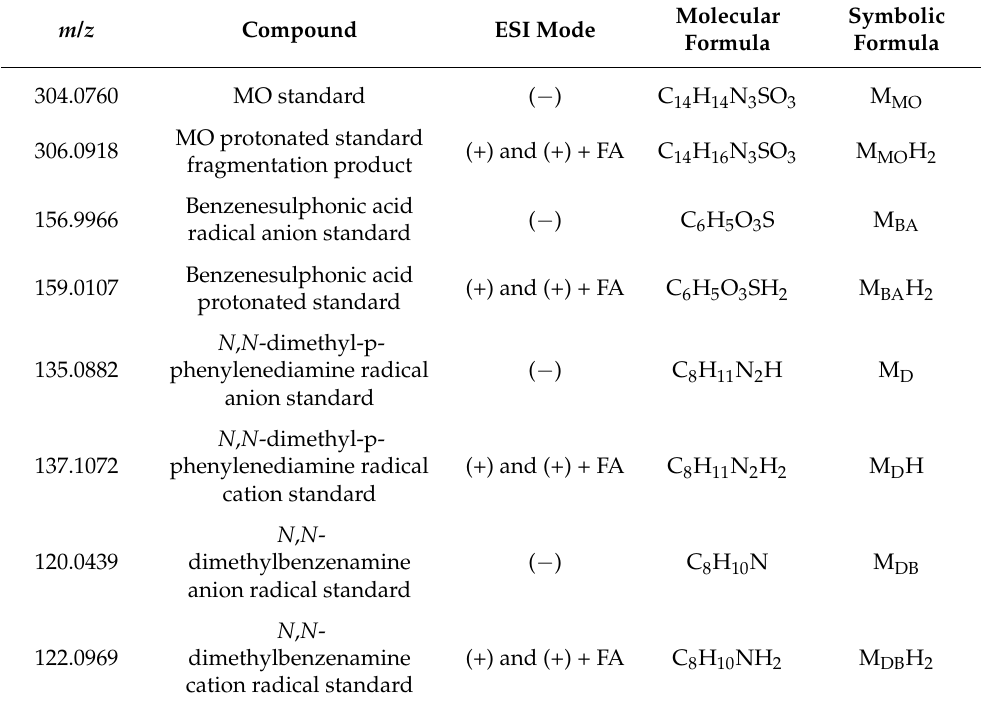
Table 3. Summary of ESI-HRMS